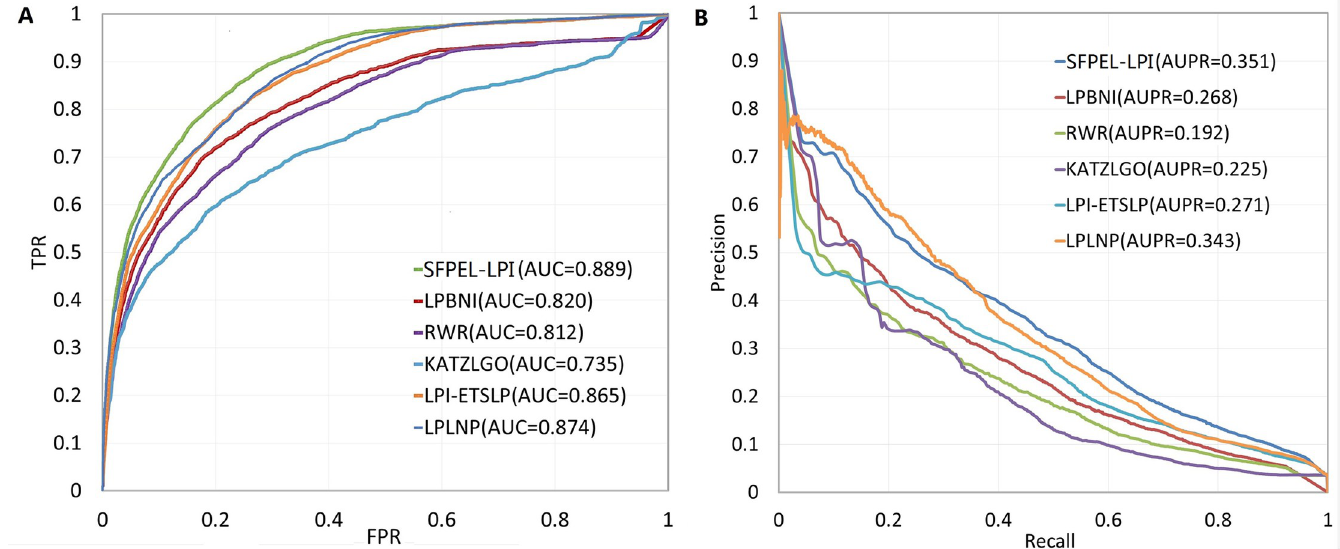
Fig 5. Performance of different methods on the perturbed dataset. (A) ROC curves. (B) PR curves.